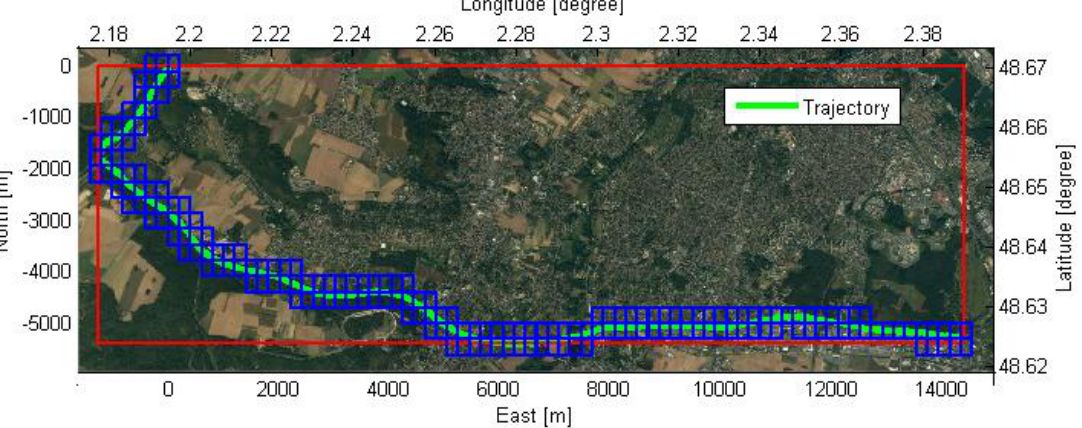
Figure 8. The test trajectory (20 km) to evaluate the large-scale coverage of the geodetic quad-tree EOGM tiles.